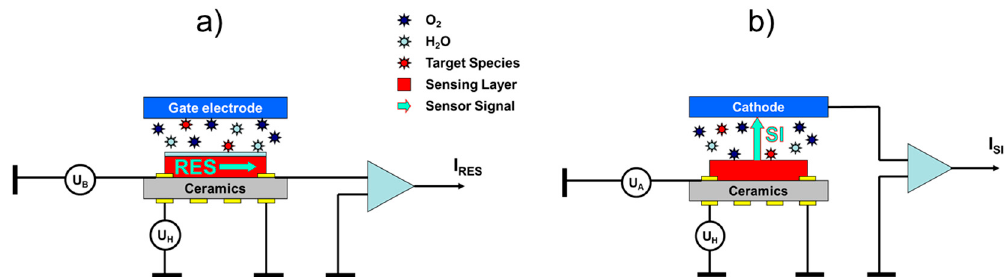
Figure 1. Metal oxide (MOX) gas sensor operated ( a ) in the conventional resistive (RES) readout mode; and ( b ) in the innovative surface ionization (SI) mode. In the RES mode, gas adsorption is monitored via changes in the in-plane resistivity of the MOX sensing layers. The suspended gate electrode is not